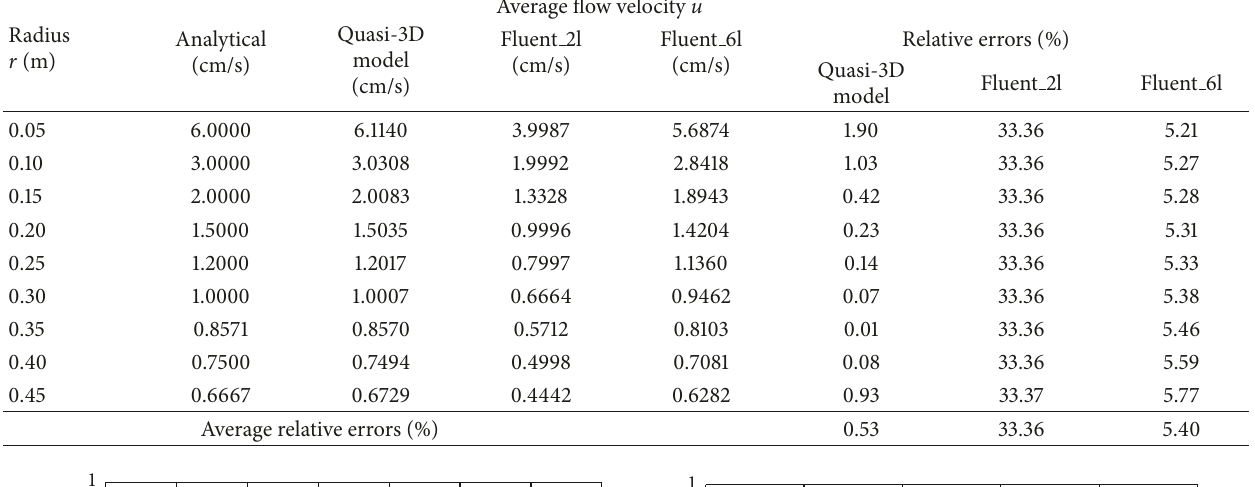
Table 5: Average flow velocity at different radiuses at t =40 s in Case 1.